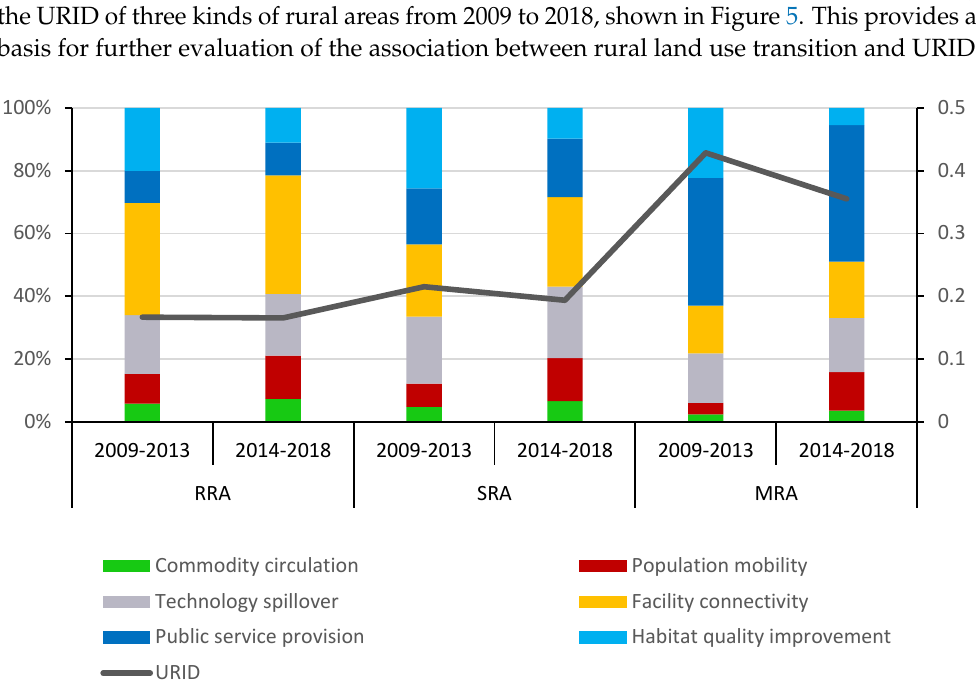
Figure 5. URID index and sub-dimensional index of three types of rural areas from 2009 to 2018.